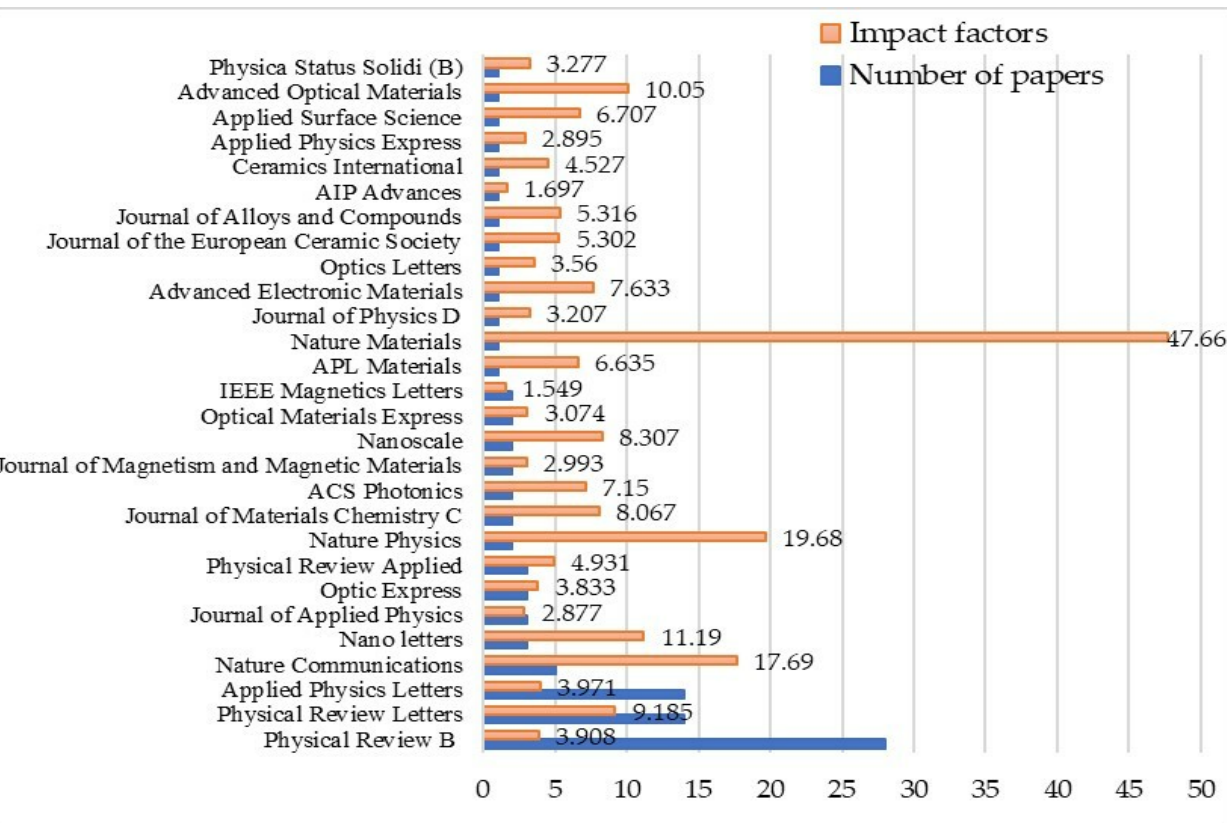
Figure 8. Evaluation of top citation papers over various journals and journal impact factors. Figure 9 examines the journals according to the publisher and active areas in YIG research. In Figure 9, 11 distinct publishers were identified for the 100 most-cited